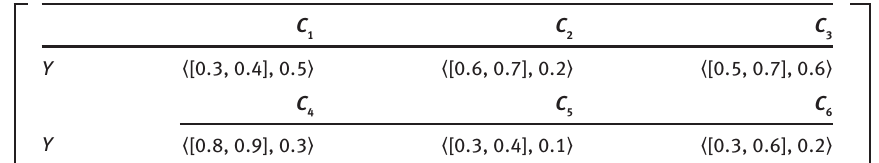
Table 5: Collective Ideal Strategy.